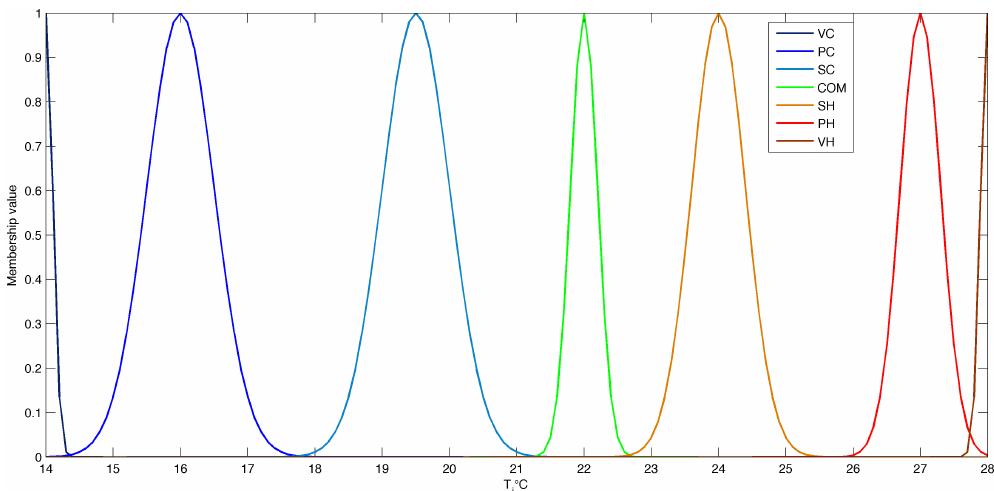
in the winter scenario. i